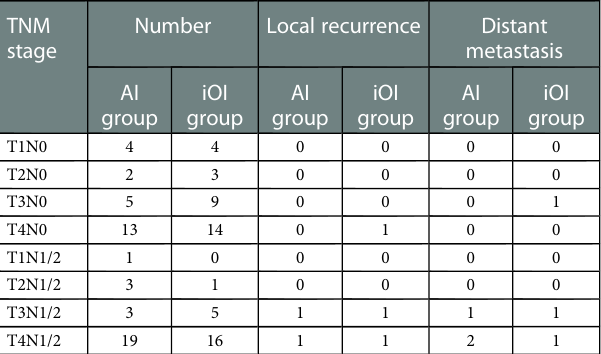
TABLE 4 Local recurrence and distant metastases in the two